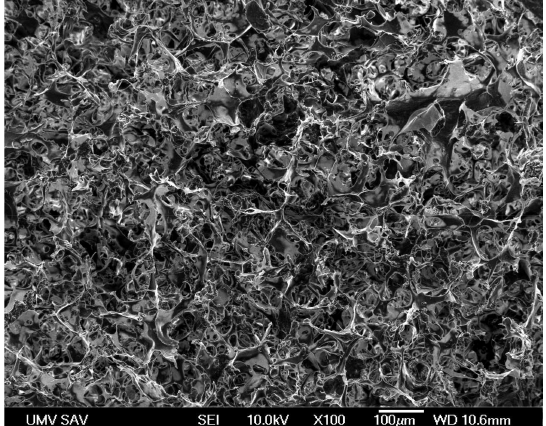
Figure 1. Scanning electron micrograph image shows the microstructure and presence of microporosity in the composite